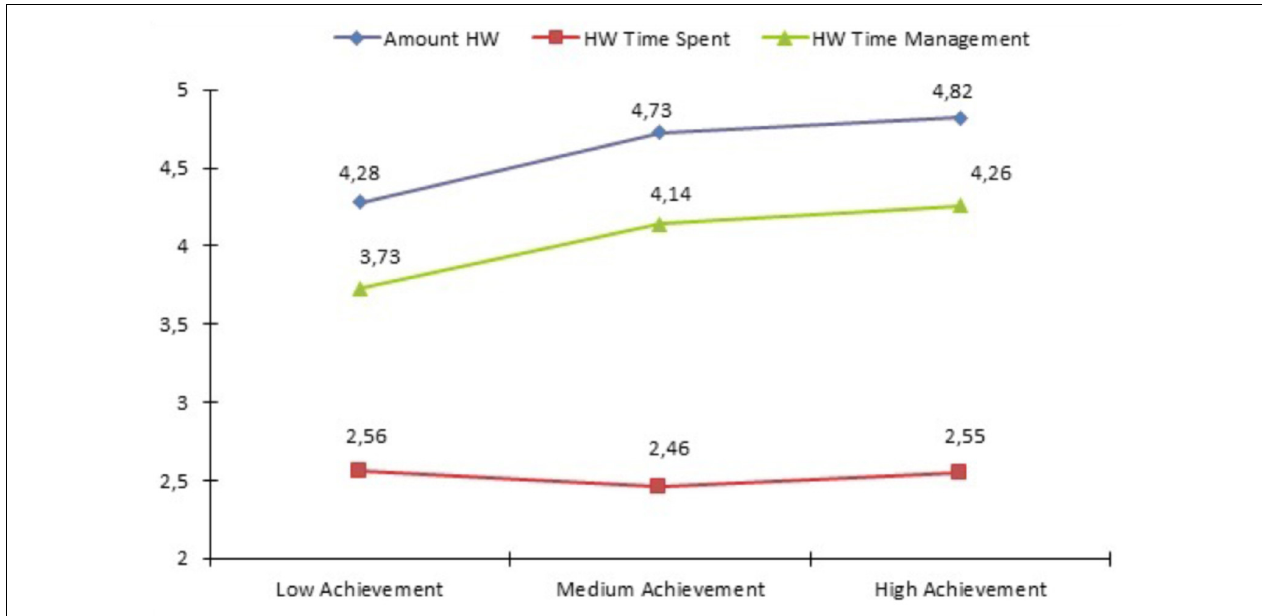
FIGURE 2 | Graphic representation of the mean values of the variables associated with behavioral engagement (amount of homework done-Amount HW-, time devoted to homework-HW Time Spent- and optimization of the time spent on homework-HW Time Management) as a function of the levels of prior academic